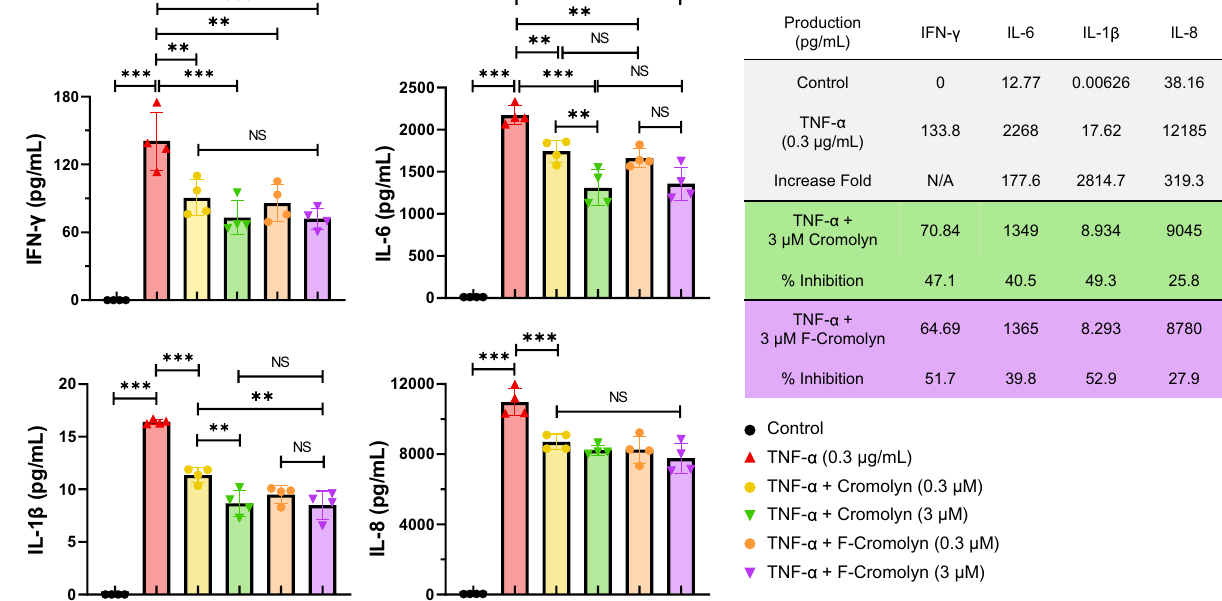
Figure 2. Cromolyn and F-cromolyn inhibit secretion of pro-inflammatory cytokines by HMC3 microglia cell line induced by TNF-α. Quantitative analyses of MSD assays indicate the dramatically increased secretion of IFN-γ, IL-1β, IL-6 and IL-8 from HMC3 cells treated with TNF-α (0.3 µg/mL, 24 h), which are subsequently reduced by cromolyn and F-cromolyn (0.3 µM and 3 µM for each). * p < 0.05, ** p < 0.01, *** p < 0.001, and NS (no significant